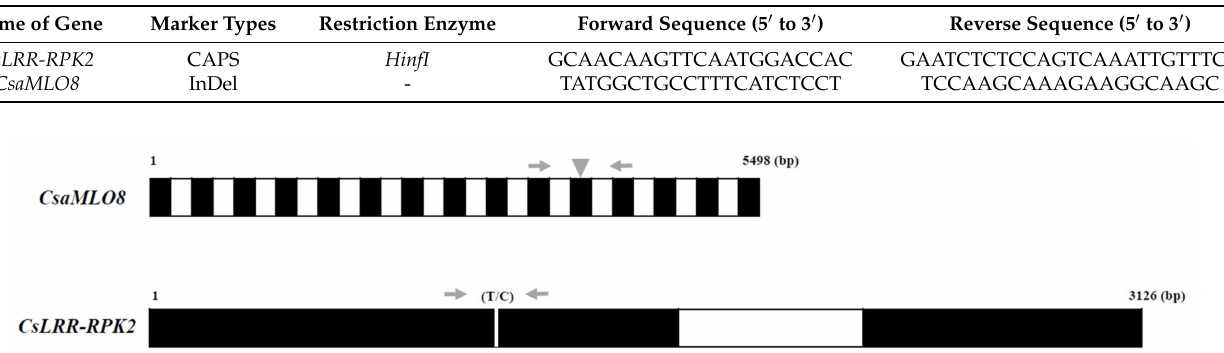
Table 3. Information on CsLRR-RPK2 -CAPS and CsaMLO8 -InDel markers.